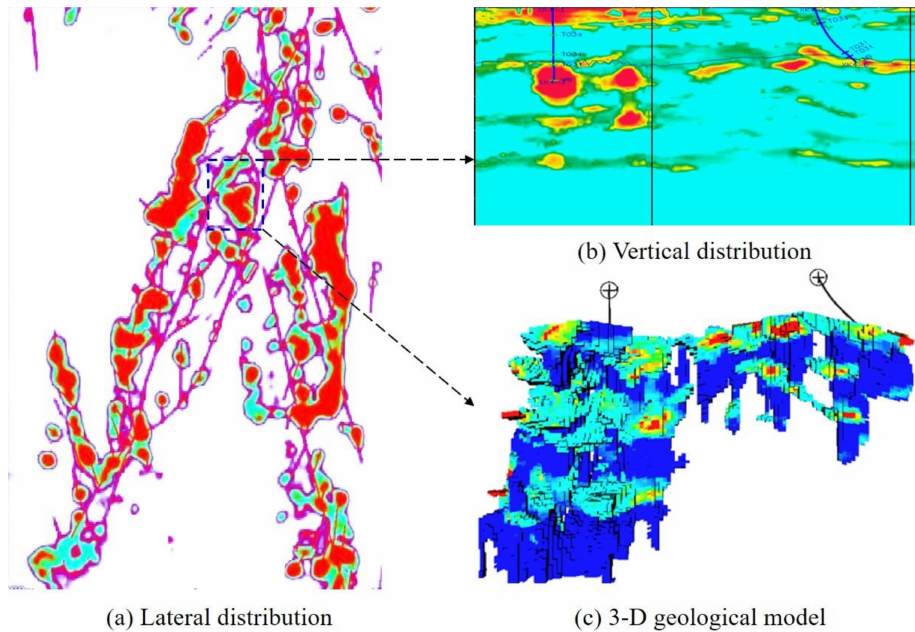
Figure 1. Geological characteristics of typical fractured-cavity reservoir. ( a ) lateral distribution of amplitude; ( b ) vertical distribution of amplitude; ( c ) 3-D geological